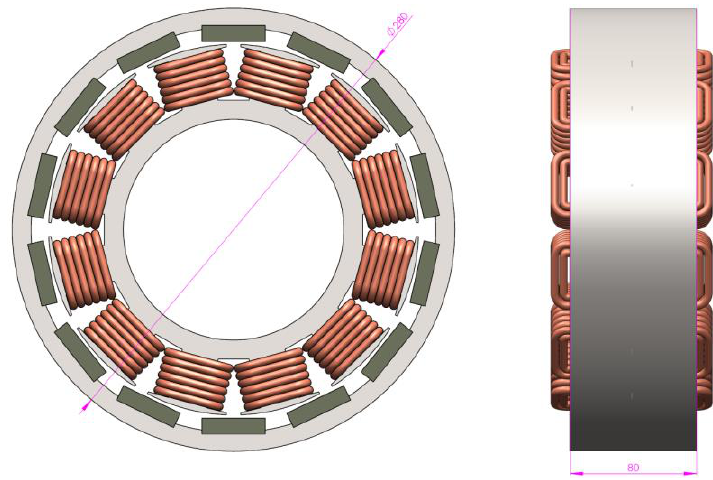
Figure 5. View of ERPMSM with chosen geometric dimensions of the electromagnetic circuit.